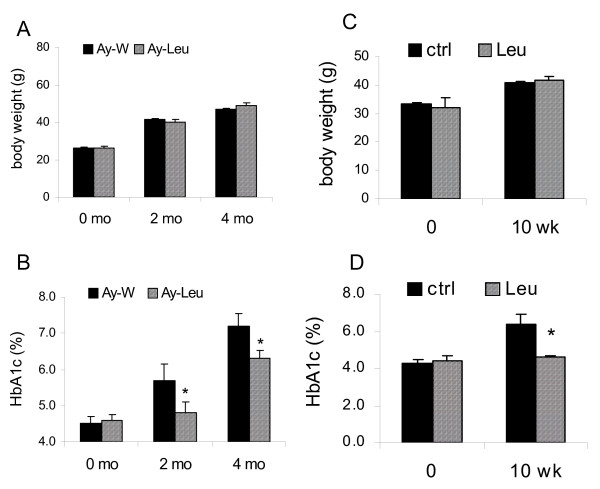
Leucine supplementation improves glycemic control independent of energy balance in yellow agouti (Ay) mice. A-B: Body weight (A) and HbA1c levels (B) of the young Ay mice before and after 2 and 4 months of leucine treatment. Leucine supplementation and breeder chow diet were started at 2 months of age (n = 8). C-D: Body weight (C) and HbA1c levels (D) of the old Ay mice before and after 10 weeks of leucine treatment. Leucine supplementation and breeder chow diet were started at 5 months of age (n = 6). * indicates p < 0.05, control vs. leucine-treated at the end of the study.